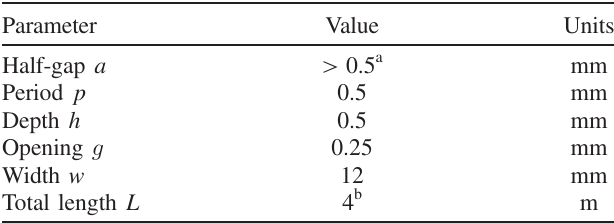
TABLE I. Structure parameters of LCLS dechirper.